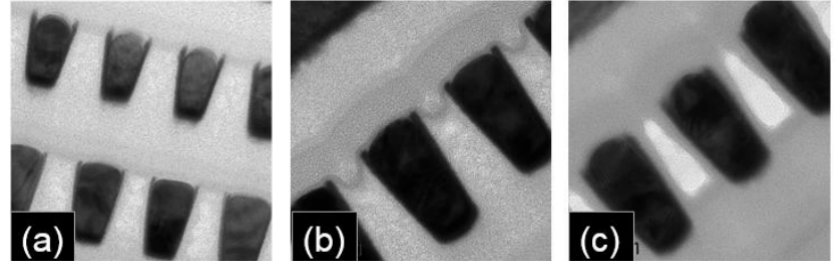
Figure 5. Cross-sectional images of ( a ) a baseline wafer without air gaps, ( b ) with air gaps excluded, and ( c ) with air gaps Reprinted/adapted with permission from Ref. [40]. 2017, IEEE..